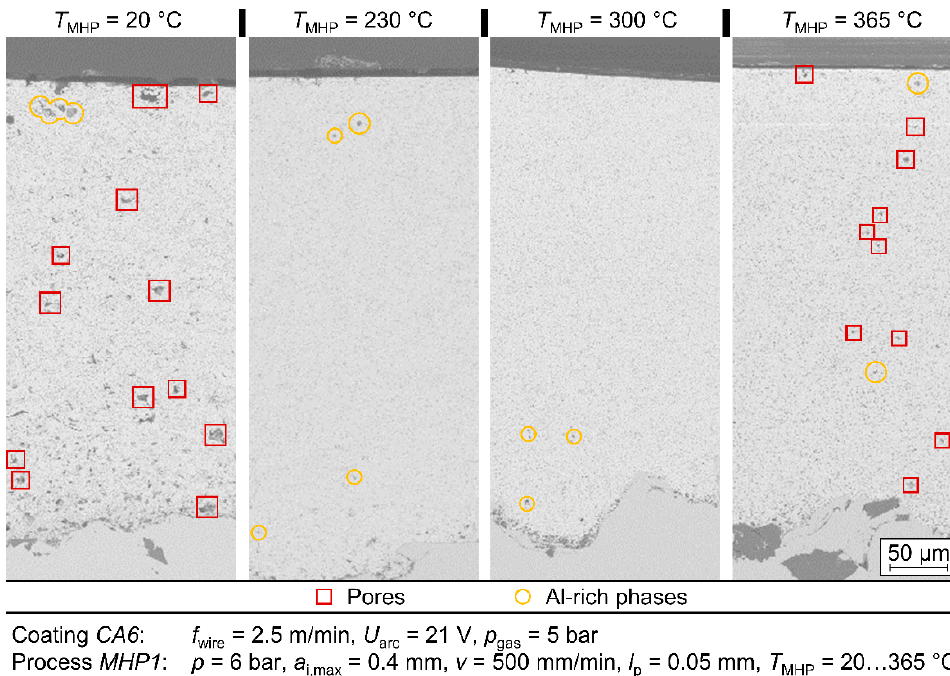
Figure 9. Scanning electrons micrographs in of ZnAl4 coatings after MHP treatment at temperatures between T MHP = 20 °C and T MHP = 365 °C with backscattered electrons detection showing a material contrast.